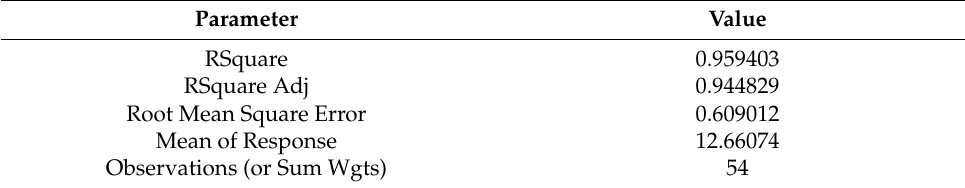
Table 2. The summary statistics of the nonlinear regression model of the layer thickness ( t h